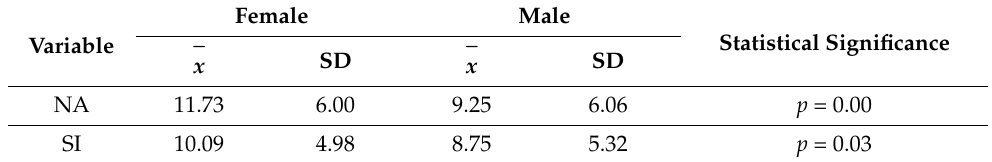
Table 3. Comparison of type D personality components (NA and SI) in group P2 in relation to gender. Female Male Variable